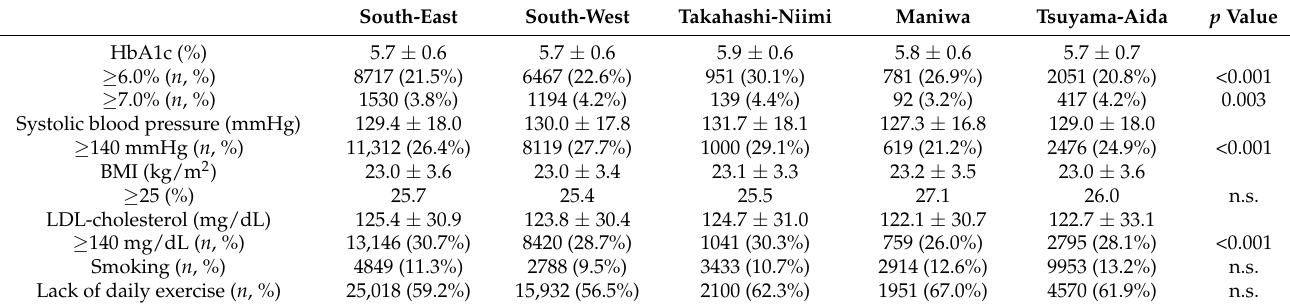
Table 2. Risk factors for